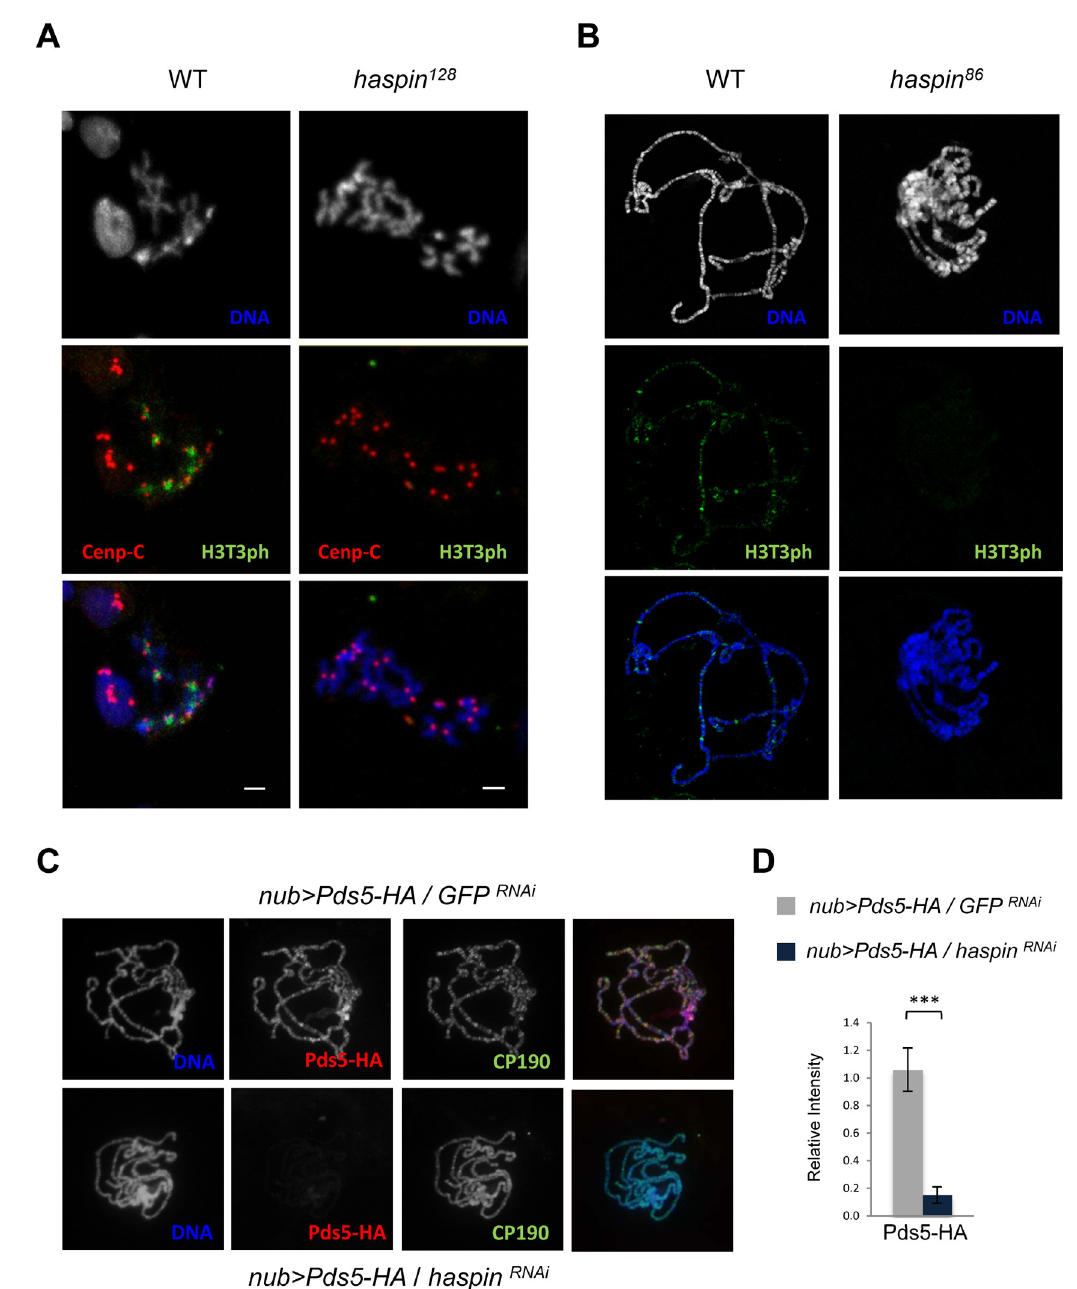
Fig 2. Haspin kinase phosphorylates H3T3 in mitosis and interphase and it is required for chromatin binding of Pds5. A) Immunolocalization of H3T3ph (green) and Cenp-C (red) in mitotic cells of wild-type and haspin 128 mutant Drosophila larval brains. DNA is stained with DAPI (blue). Scale bars are 2 μ m. B) Representative polytene chromosome spreads from wild-type and haspin 86 mutant salivary glands of third-instar larvae immunostained with antibodies against H3T3ph (green). DNA is stained with DAPI (blue). C) Representative polytene chromosome spreads from salivary glands of third-instar larvae that express Pds5-HA under the control of nubbin promoter in GFP (upper panels) or haspin (lower panels) RNAi backgrounds, immunostained with antibodies against HA (red) and CP190 (green). DNA is stained with DAPI (blue). D) Pds5-HA/CP190 immunofluorescence intensity ratio in polytene chromosome spreads from salivary glands of third-instar larvae that express Pds5-HA under the control of nubbin promoter in GFP or haspin RNAi backgrounds. n = 5, means and s.d. are shown. ��� p < 0.001 was determined by Student’s t -test.